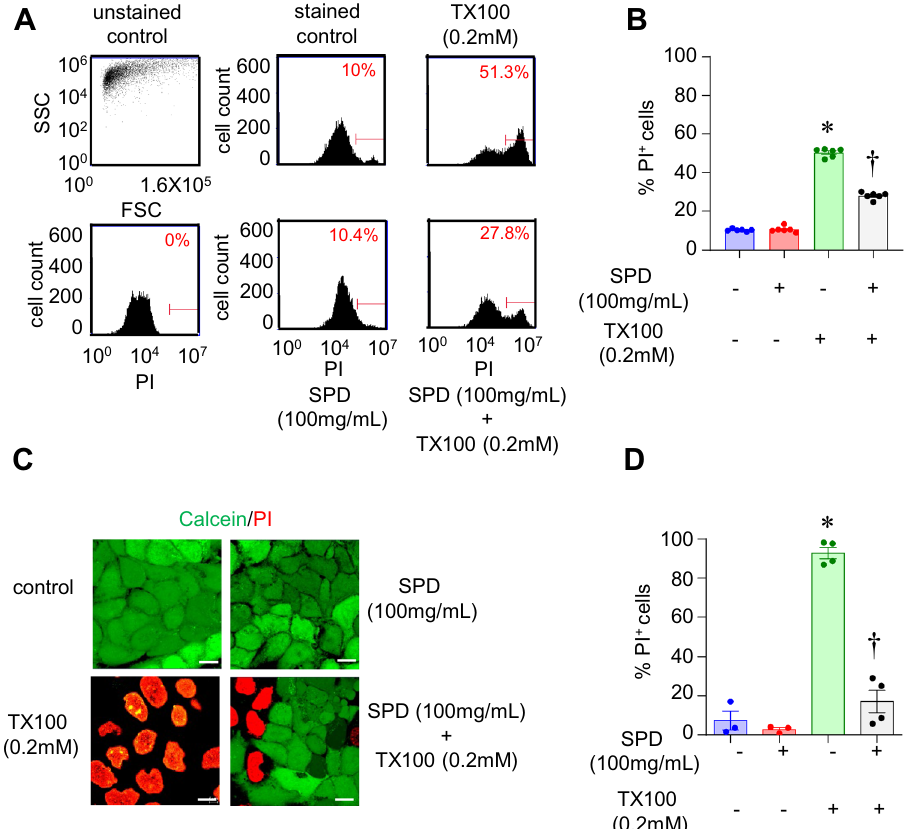
Figure 3. Prolonged efficacy of SPD against TX100-induced cell death. Human keratinocytes (HaCaT) were first co-treated with SPD (100 mg/ml) and TX100 (0.2 mM) for 3 h. Cells were subsequently washed with PBS and incubated in a fresh medium for 24 h containing SPD and then analyzed for cell death by flow cytometry and confocal microscopy. ( A , B ) Flow cytometry histograms and quantification of %PI-positive cells. Data represent mean ± SEM (n = 6). * p < 0.05 compared to control (TX100-untreated). † p < 0.05 compared to TX100- treated group. ( C , D ) Confocal microscopy images and quantification of %PI-positive cells. Scale, 10 µm. Data represent mean ± SEM (n = 3–4). * p < 0.05 compared to control (TX100-untreated). † p < 0.05 compared to TX100-treated